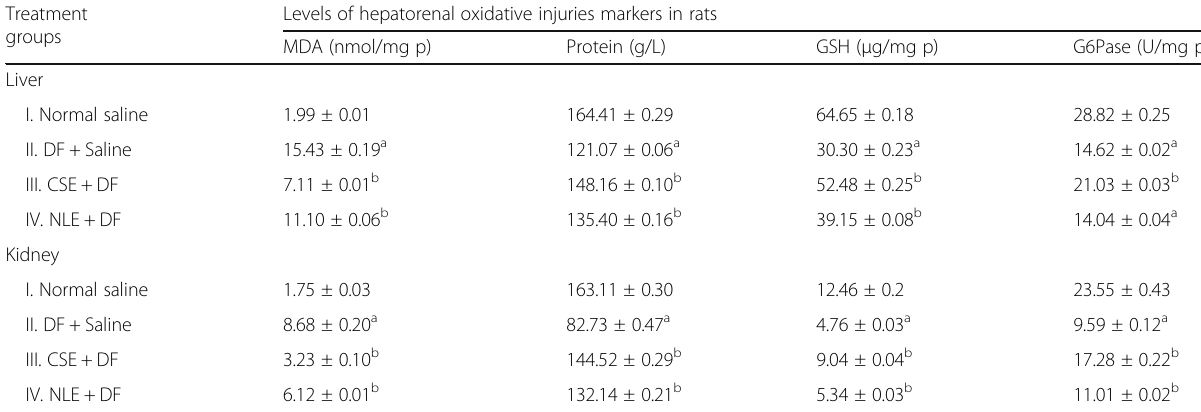
Table 3 Effect of CSE and NLE on levels of Proteins, MDA, GSH and G6Pase in hepatorenal tissues of DF-exposed rats Treatment